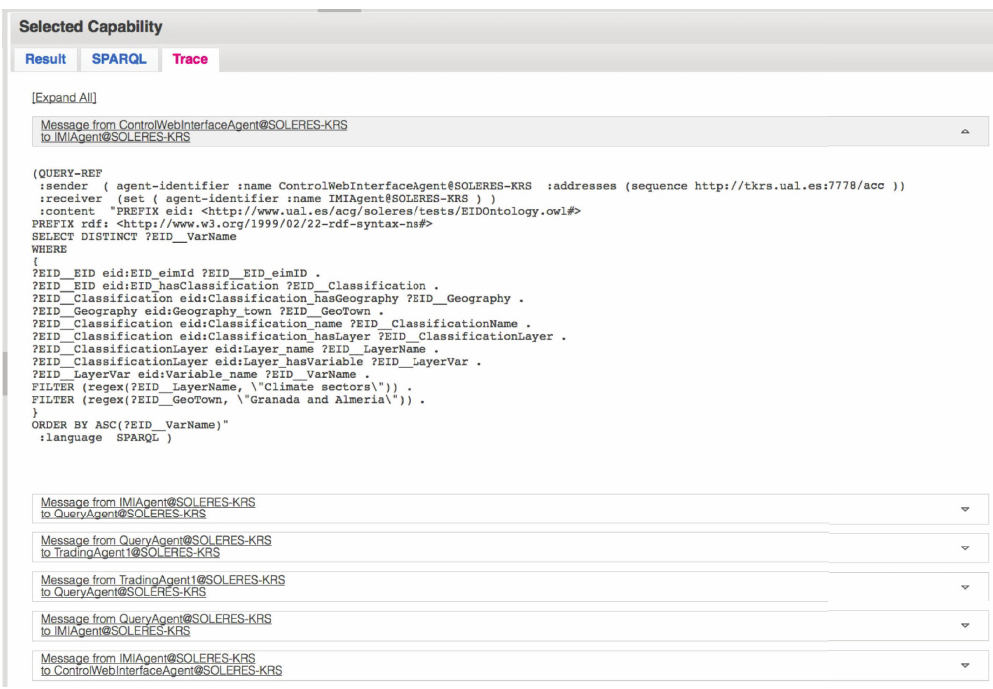
Figure 15: Trace of messages sent between agents after the